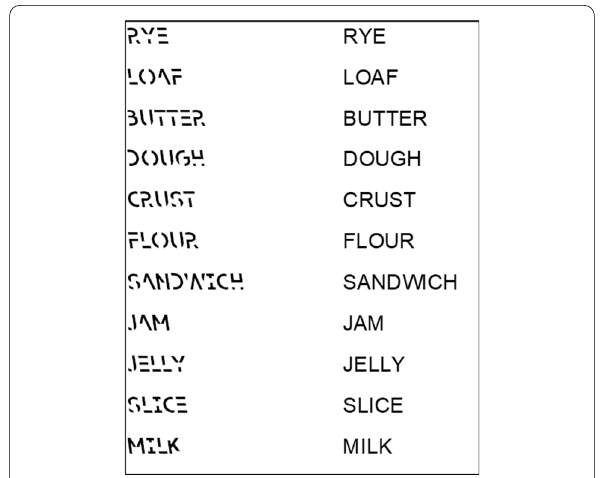
Fig. 1 Examples of DRM lists presented using Sans Forgetica font (left) and Arial font